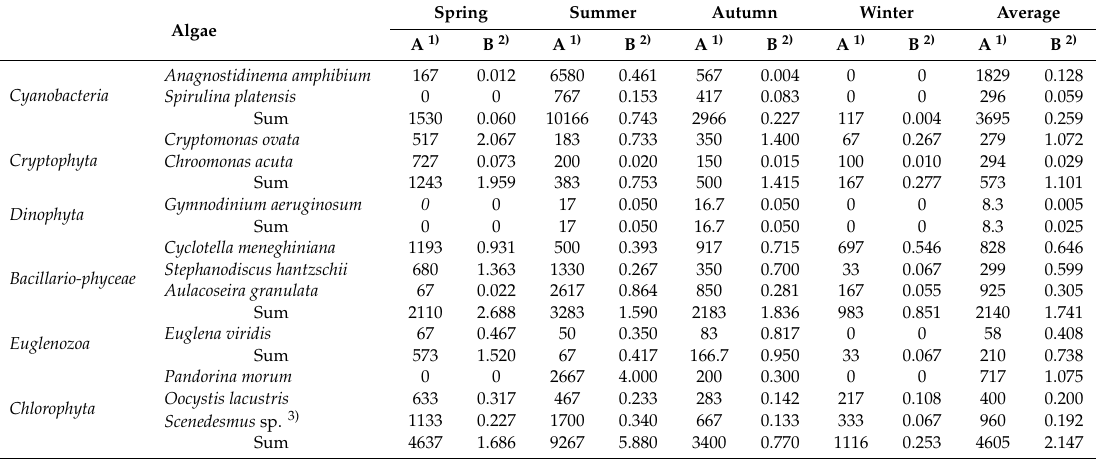
Table 1. The seasonal changes of the abundance and biomass of the dominant planktic algae.